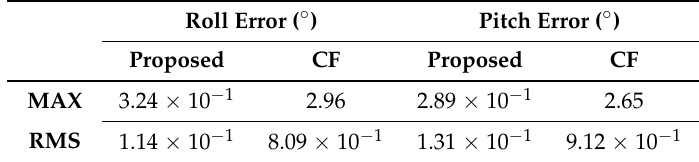
Figure 9. ( a ) Roll and pitch estimate comparison in the kinematic vehicle experiment; ( b ) Roll and pitch estimate error comparison in the kinematic vehicle experiment. Table 4. Max and RMS of roll and pitch error in the kinematic vehicle experiment.